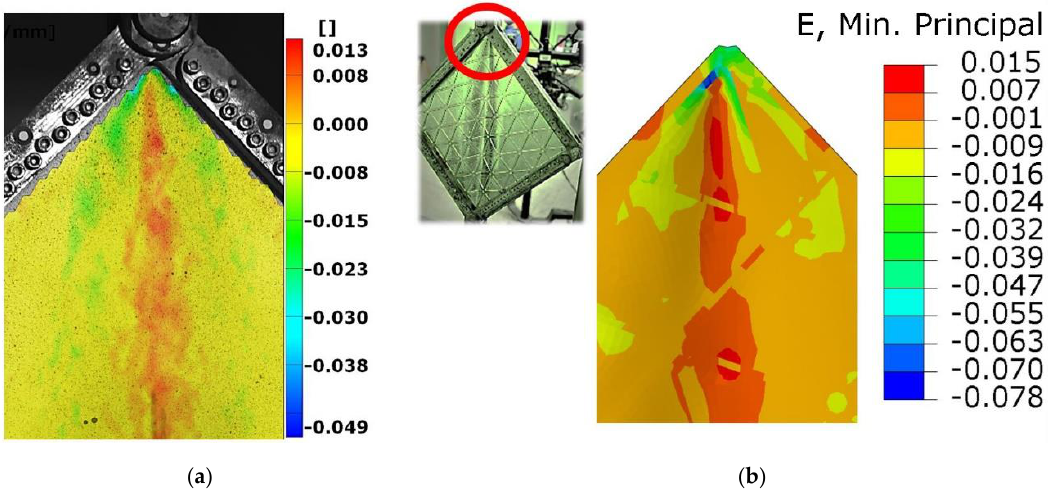
Figure 16. Comparison of the minimum principle strain distribution at the maximum load. ( a ) Experimental DIC result, ( b ) numerical result.